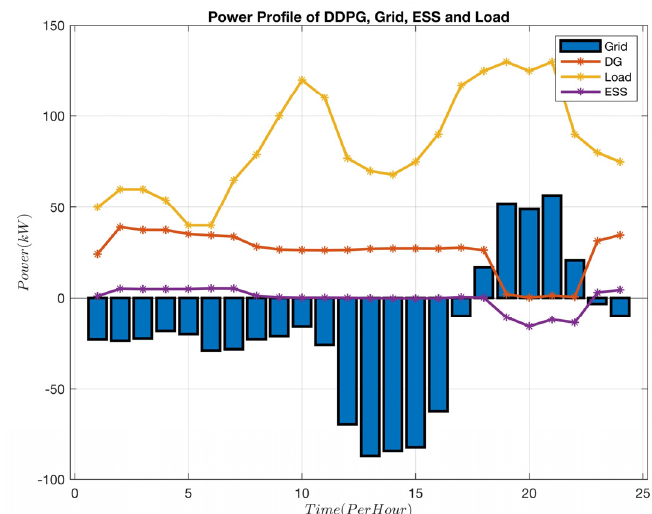
Figure 5. Power profile of DDPG, grid, BESS, and load .